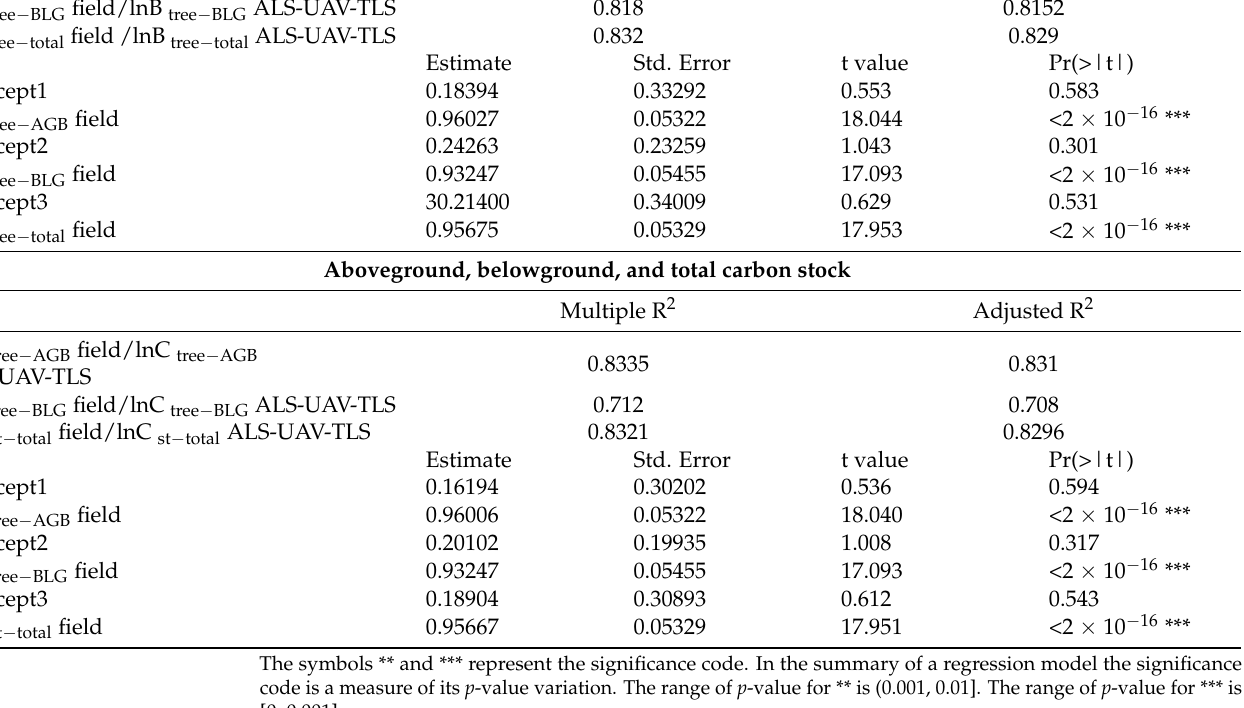
Figure 11. Relationship between C1.30m and tree heights measured in the field and those extracted from ALS-UAV-TLS data, represented using linear regression with logarithmic transformation.